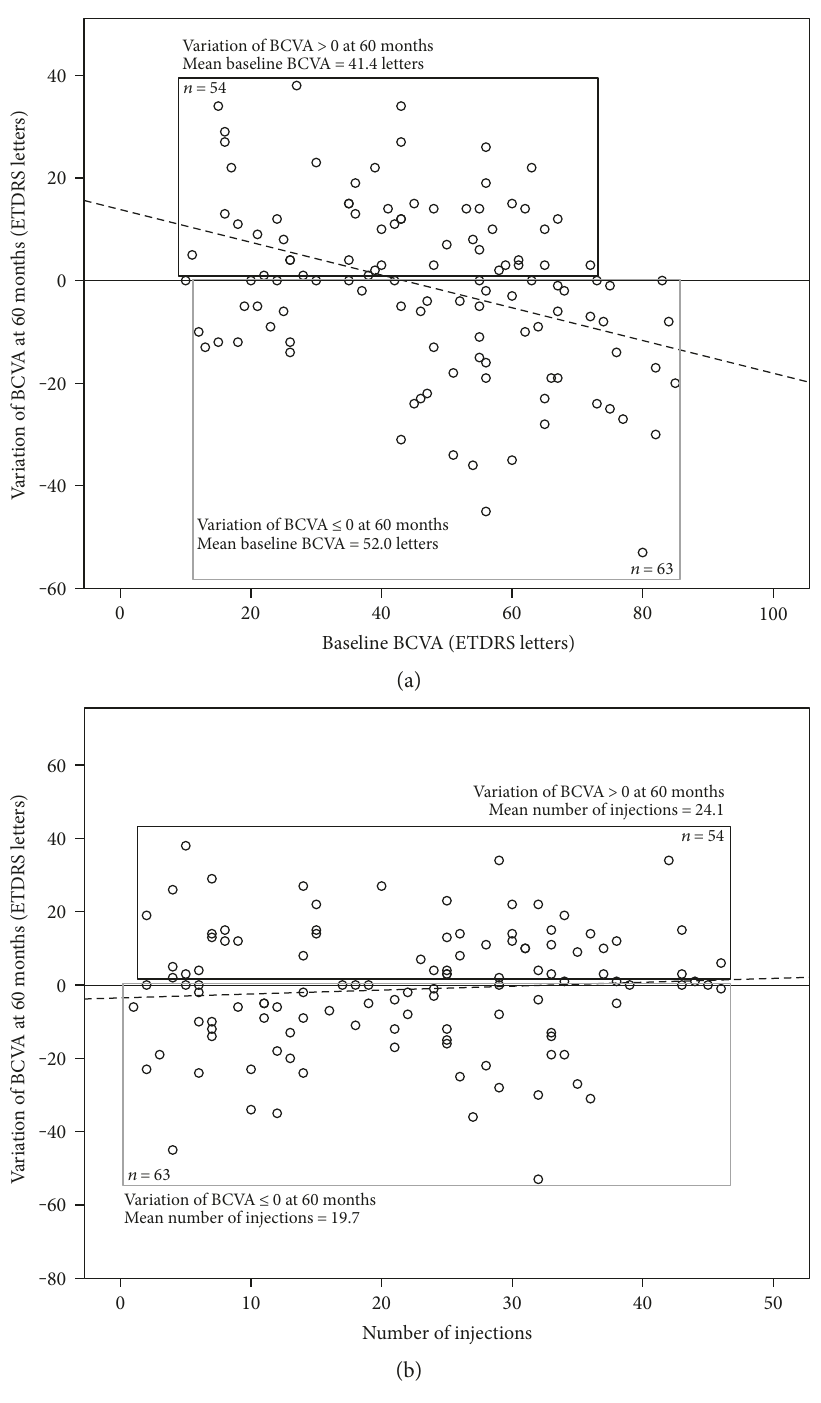
Figure 3: Predictive variables of best-corrected visual acuity variation at 60 months. (a) Worse BCVA at baseline predicted higher BCVA variation and greater likelihood of achieving a variation greater than 0 ETDRS letters, at 60 months. Dashed lined = fi tted simple linear regression line. (b) Higher number of injections predicted greater likelihood of achieving a BCVA variation greater than 0 ETDRS letters, at 60 months. Dashed lined = fi tted simple linear regression line. BCVA, best-corrected visual acuity; ETDRS, early treatment diabetic retinopathy